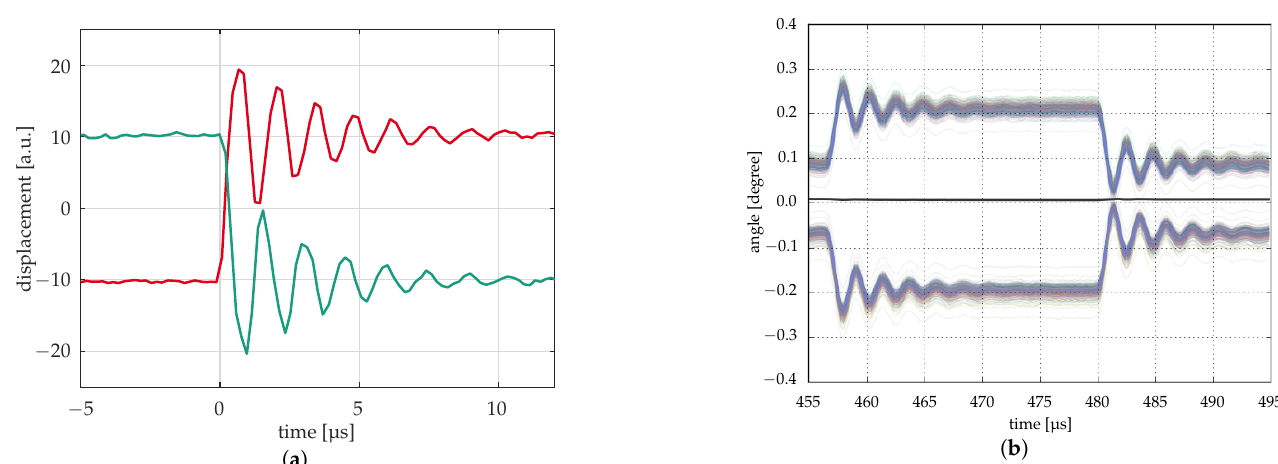
Figure 12. Dynamic measurements. ( a ) Early measurements of mirror response by laser vibrometer (two mirrors); ( b ) Mea- surement of mirror response by optical profilometry with stroboscopic illumination (ca. 450 mirrors)